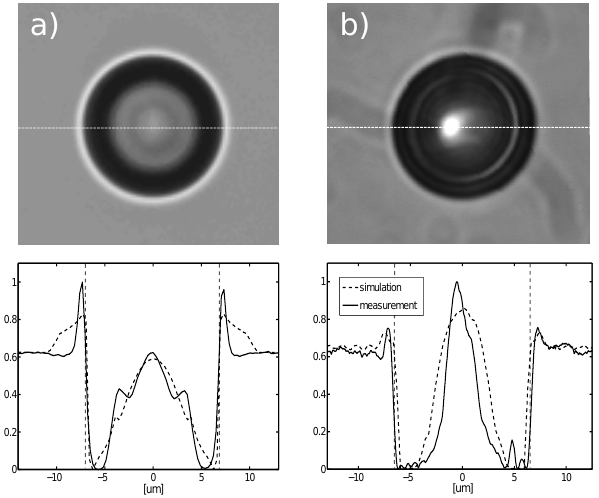
Figure 3. Comparison of two optical images of the same bubble seen through different imaging systems and their measured and sim- ulated profiles along the dotted line shown in the images. (a) Objec- tive NA 1.4 and condenser NA 0.4, (b) objective NA 0.8 and con- denser NA 0.2. The outer rim is visible in both images and profiles, but much less pronounced in the low NA image on the right. The optically determined radii, (a) 6.75 and (b) 6.9µm, are highlighted as vertical dashed lines in the